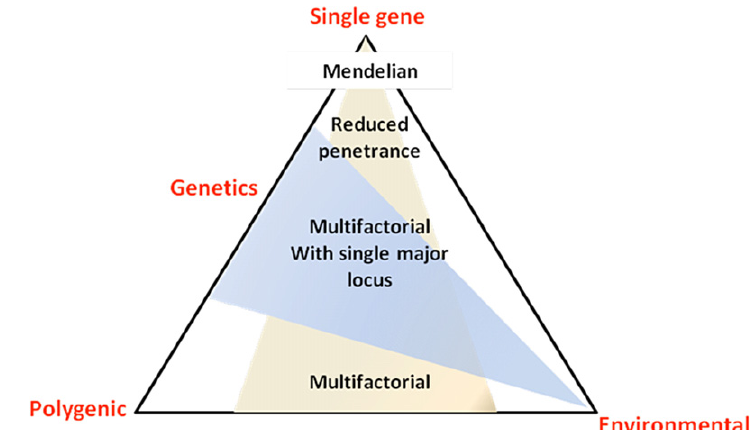
Figure 11. Role of genetic and environmental factors in determining the spectrum of the disease phenotype. (Strachan T, Read AP. Genes in pedigrees and populations in Human molecular genetics 3. 3rd ed. London; New York: Garland Press; 2004)